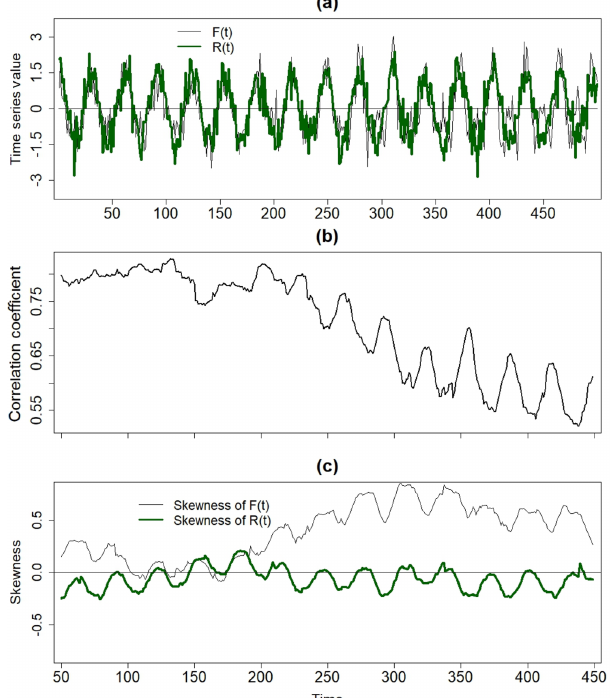
Figure 1. (a) An idealized nonlinear forcing time series, together with an idealized response R(t) . The 120 point sliding correlation between F(t) and R(t) . (c) The 120 point sliding skewness of F(t) and R(t) .